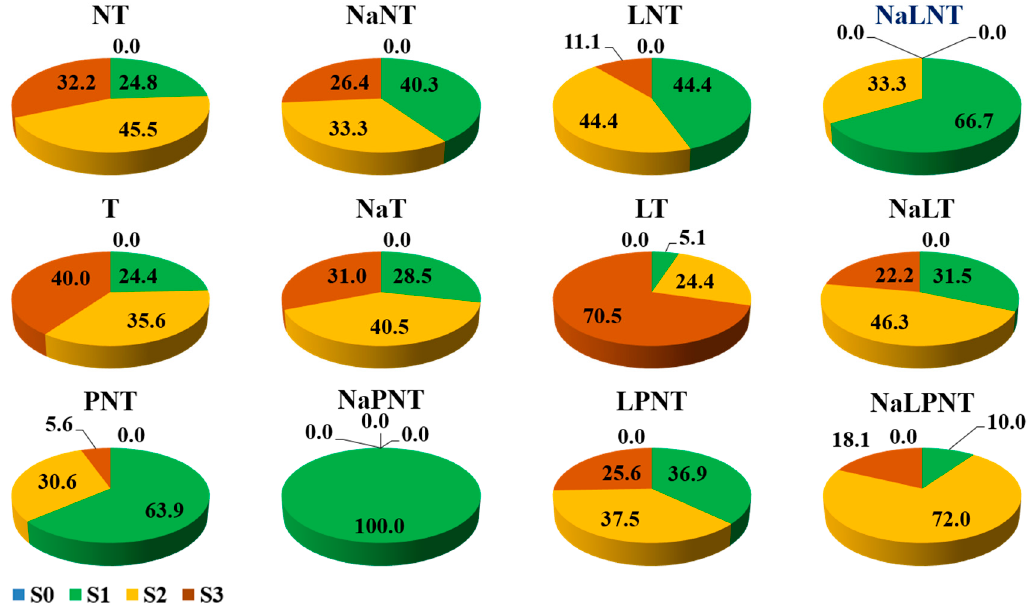
Figure 2. The extent of browning of the petal explants observed at 28 days after culture initiation: S0, no browning; S1, slight browning; S2, definite browning; and S3, extreme browning. Refer to Figure 1 for details on the different denotations.